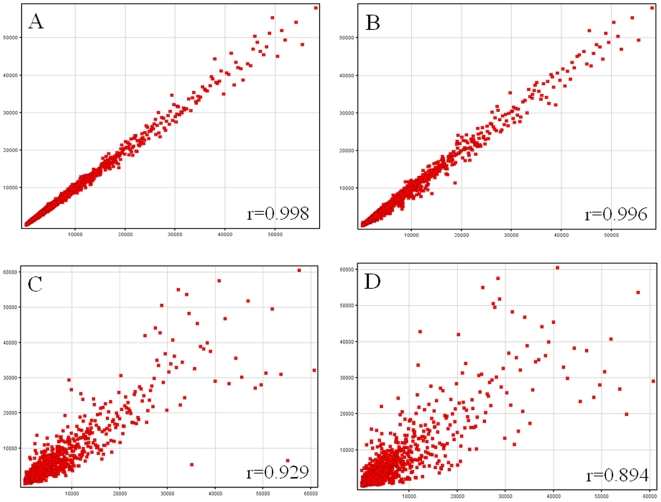
Scatter plots representation of signal intensities.Scatter plot of technical replicates: (A) same reference RNA undergoing two different hybridization or (B) same reference RNA from two different labeling runs. Typical scatter plots of data obtained from two patients (C) or a patient and a control (D). Pearson correlation coefficient is indicated in each scatter plot.